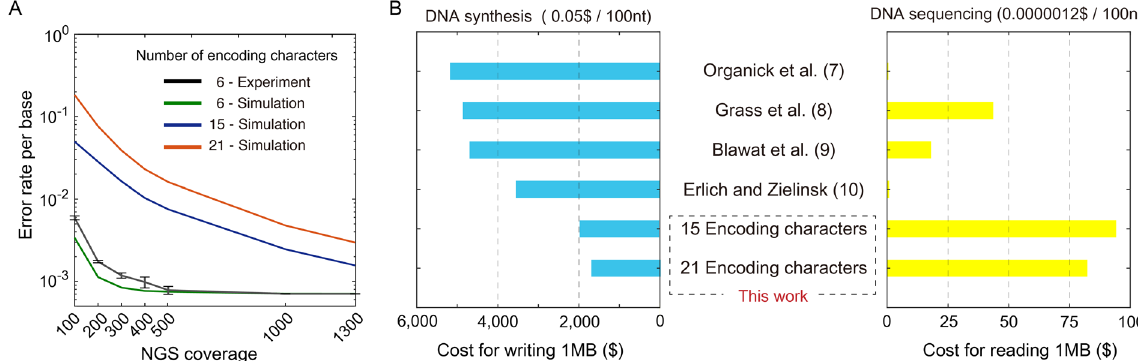
Figure 3. Error rate and cost for DNA-based data storage were analyzed. ( A ) The error rate per base pair according to the average NGS coverage over all fragments. The black line shows the experimental results, and the other three lines represent the Monte Carlo simulation results. For the experiment and simulation shown in green, we used A, C, G, T, W, and S for encoding. For the simulation shown in blue, we used A, C, G, T and all other degenerate bases. For the simulation shown in red, we used A, C, G, T, [R, Y, M, K, S, W – ratio of bases mixed of 3:7 and 7:3], H, V, D and N. The standard deviation of the experimental results were obtained by repeating the random sampling 5 times. The error bars represent the s.d. ( B ) The proposed platform is estimated to reduce the cost of DNA-based data storage by 50%. For the calculation, we assumed the cost of inkjet-based oligonucleotide pool synthesis reported by Erlich and Zielinski 10 . The cost of DNA sequencing was reported by K. Wetterstrand 22 . We used A, C, G, T and all other eleven degenerate bases as encoding characters. Additionally, we used A, C, G, T, [R, Y, M, K, S, W – ratio of bases mixed of 3:7 and 7:3], H, V, D and N as 21 encoding characters. The numbers indicate the corresponding reference. Details on the estimation method are described in the Supplementary